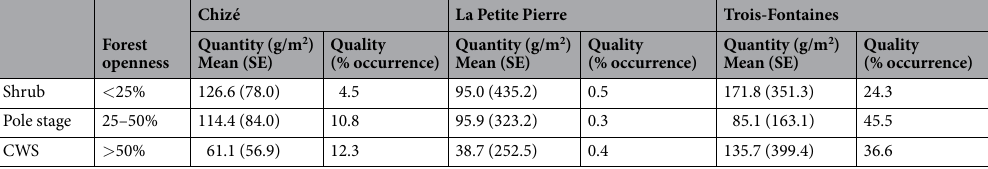
Table 1. Mean vegetation biomass (i.e., a proxy of forage quantity), occurrence of hornbeam (i.e., a proxy of forage quality) and forest openness estimated as the horizontal visibility at 25 meters from each habitat patch centroid (i.e., a proxy of protective cover) characterizing each habitat type in the three study areas located in France. CWS = coppice with standards.